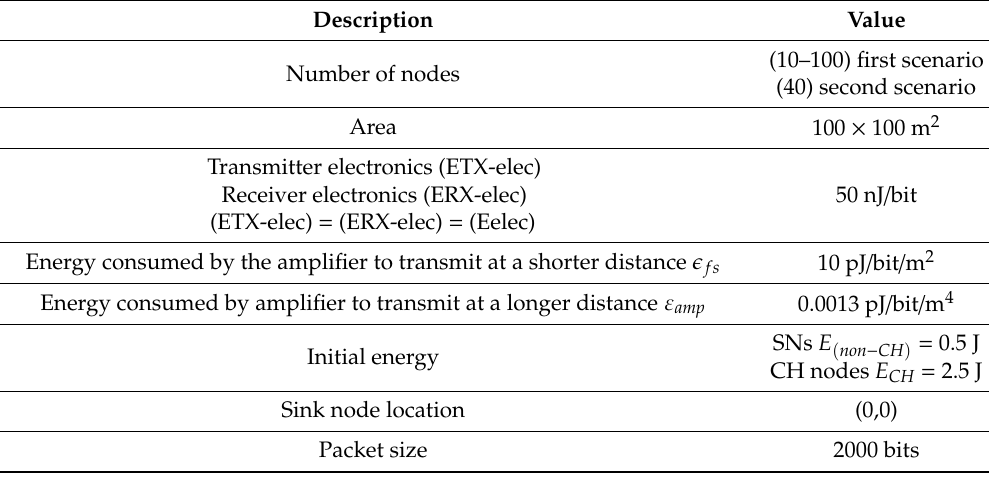
Table 1. Simulation parameters used in